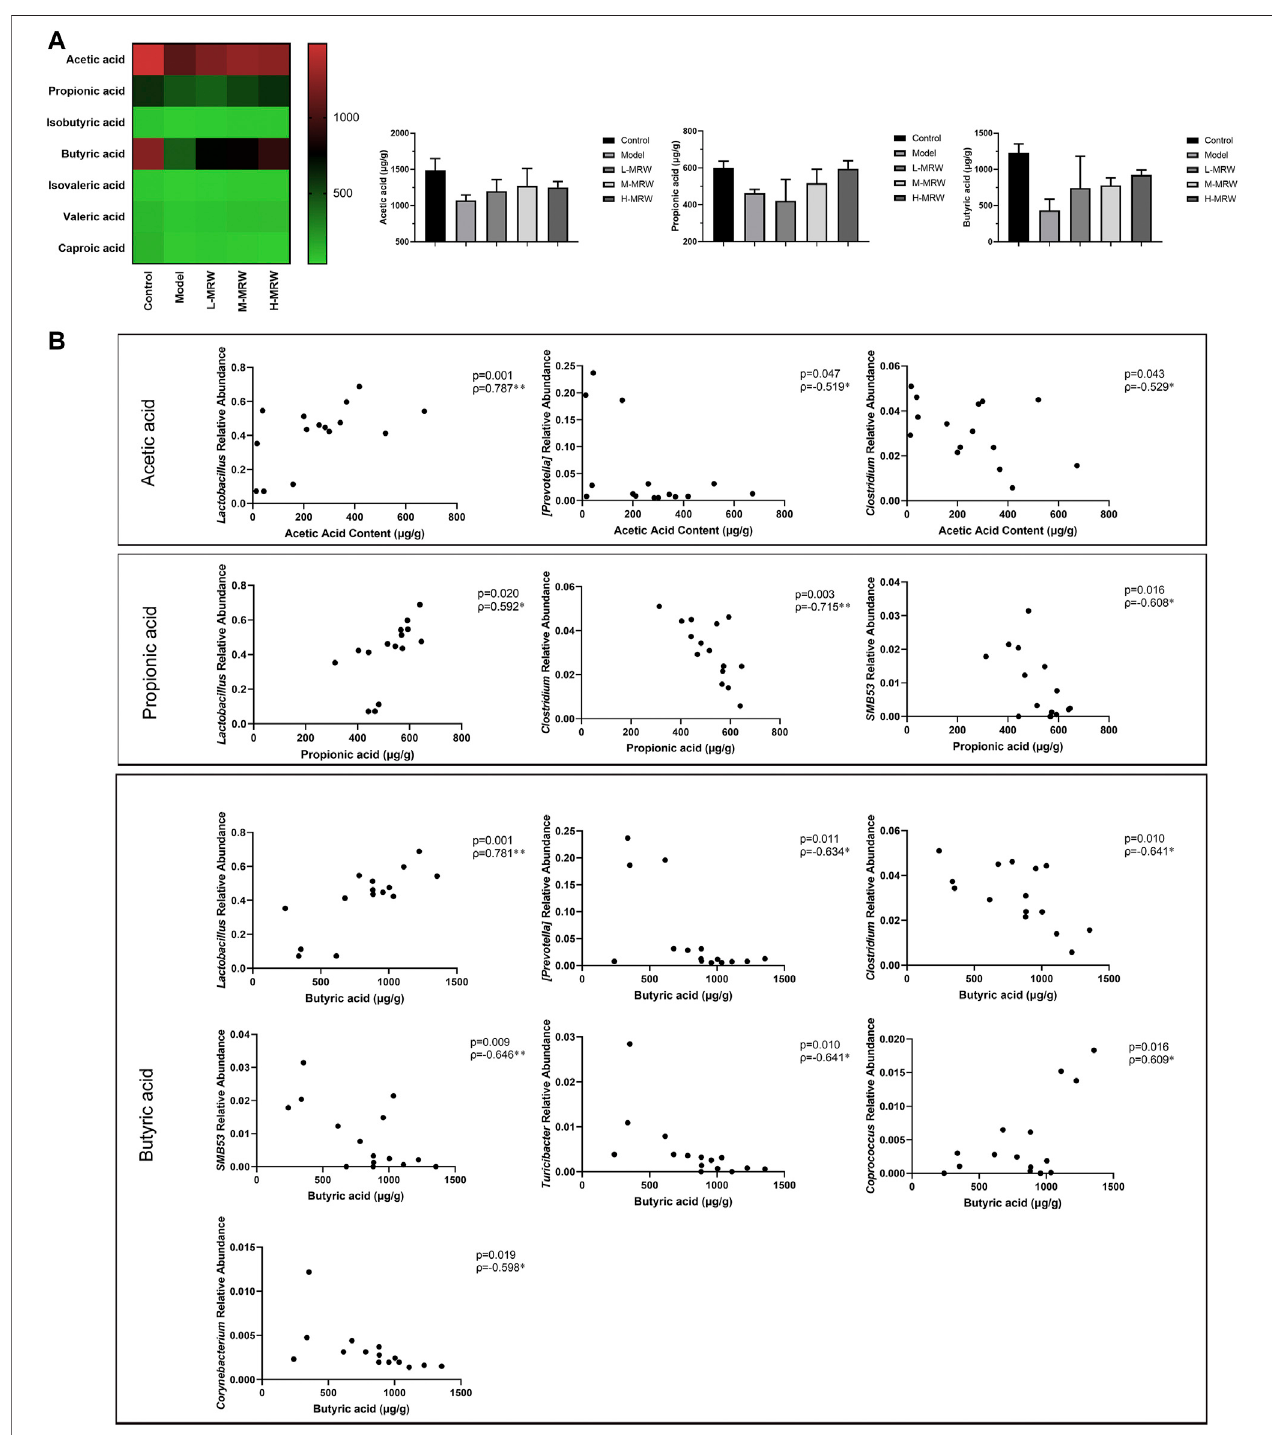
FIGURE 5 | Effects of MRW on short-chain fatty acids (SCFAs) in colonic contents of the STC rats and Pearson correlations. (A) SCFAs ’ results. (B) Pearson correlations. The data were normally distributed and analyzed by the Pearson correlation analysis.